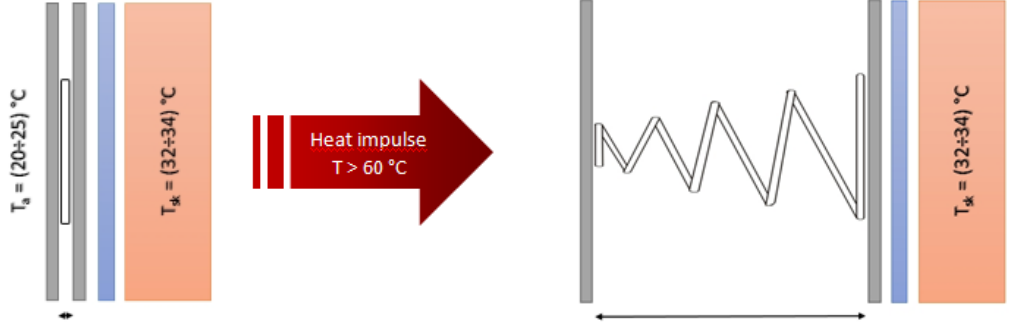
Figure 1. Idea of smart material with shape memory alloy (SMA) elements in the form of springs.